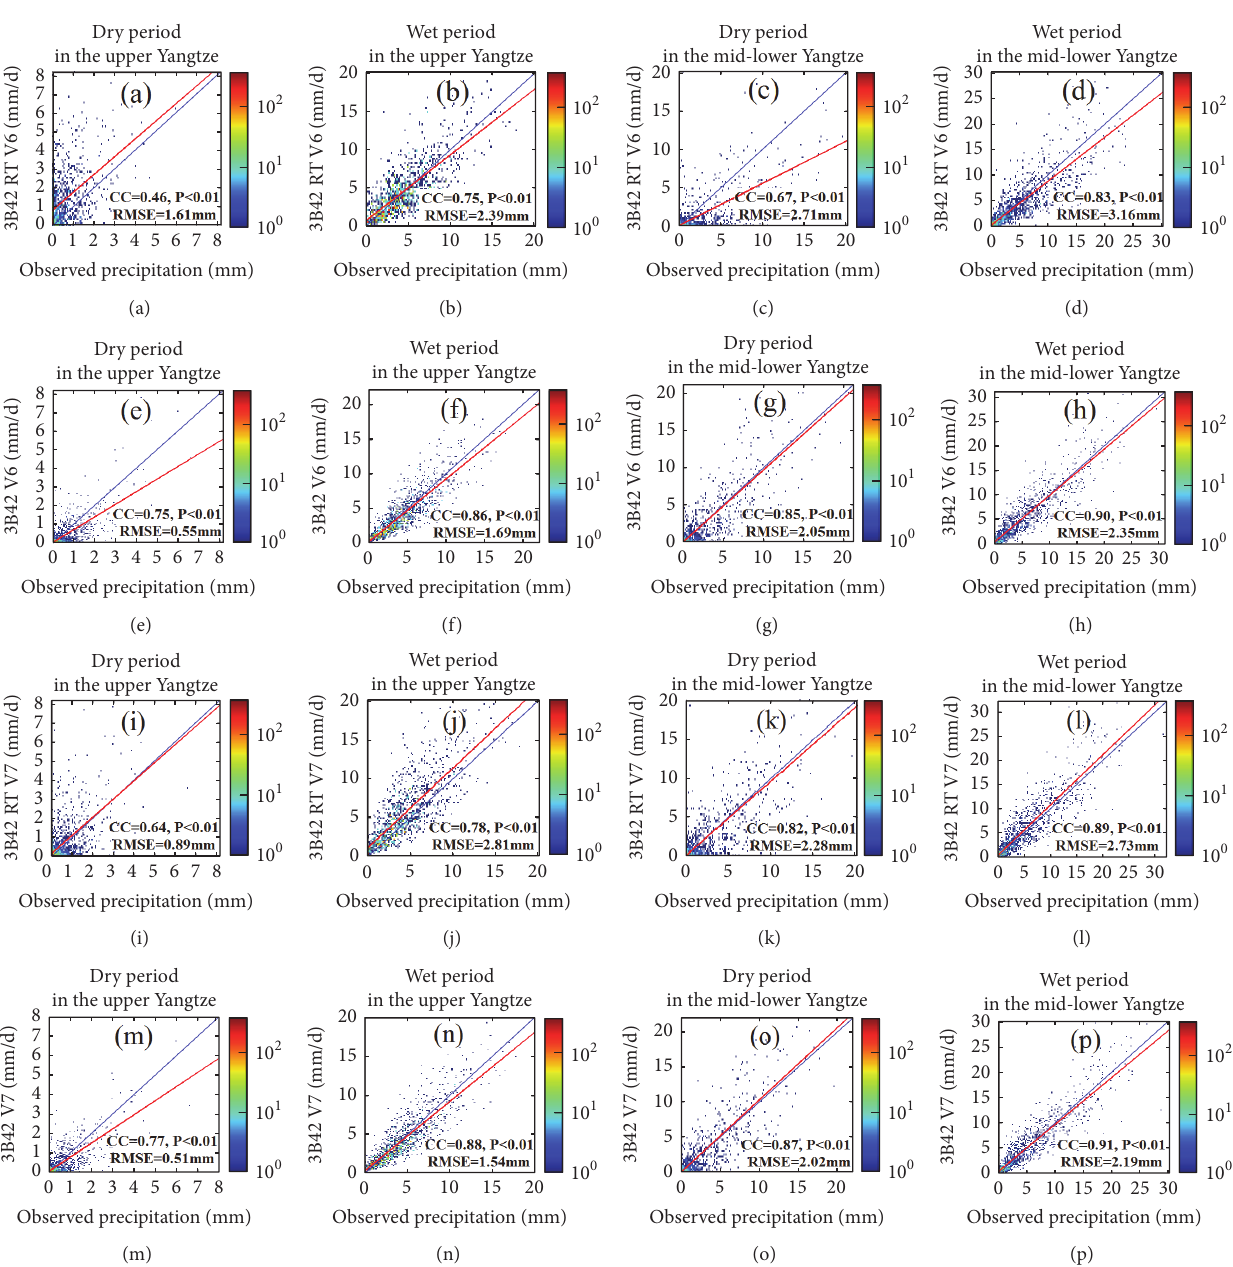
Figure 6: Scatter plots of TMPA versus observed daily mean precipitation for the dry period and wet period in the Yangtze River